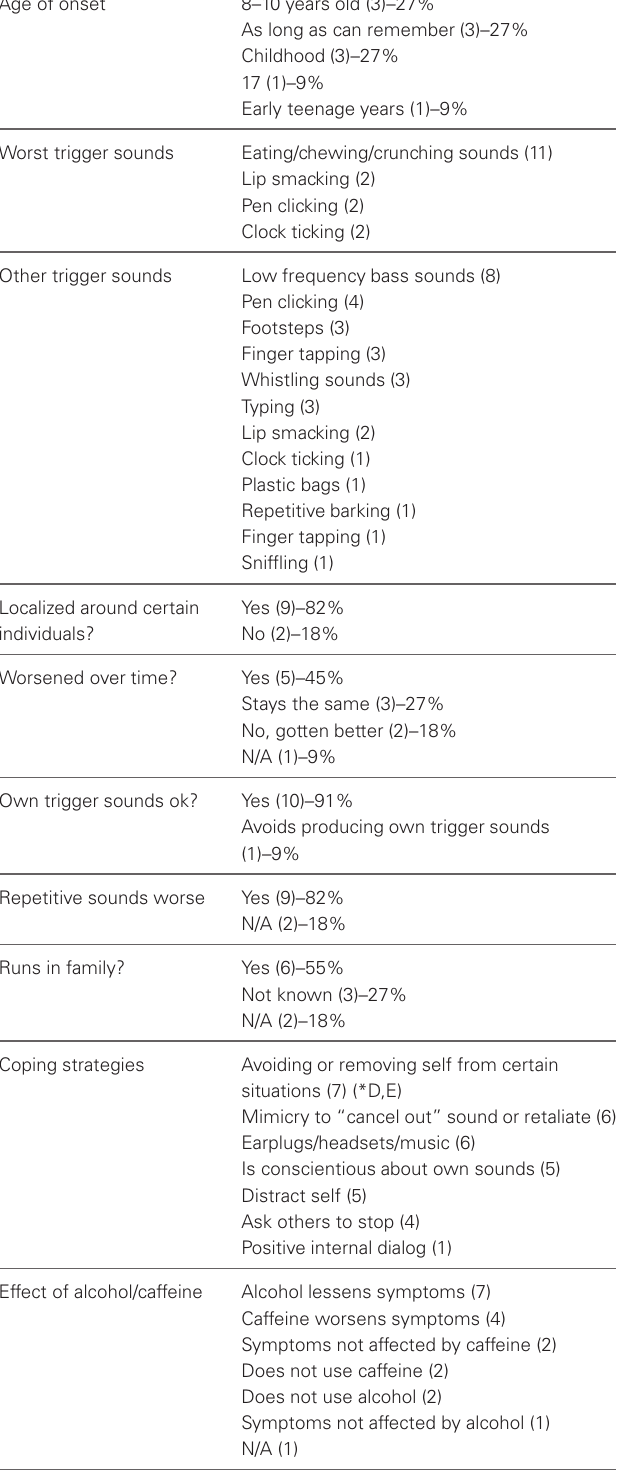
Table 1 | Summary of qualitative data gathered from interviews of the 11 misophonic subjects (4 males and 7 females, mean age = 35.82; range = 19–65) in Experiment 1, broken down into 18 of the most salient diagnostic